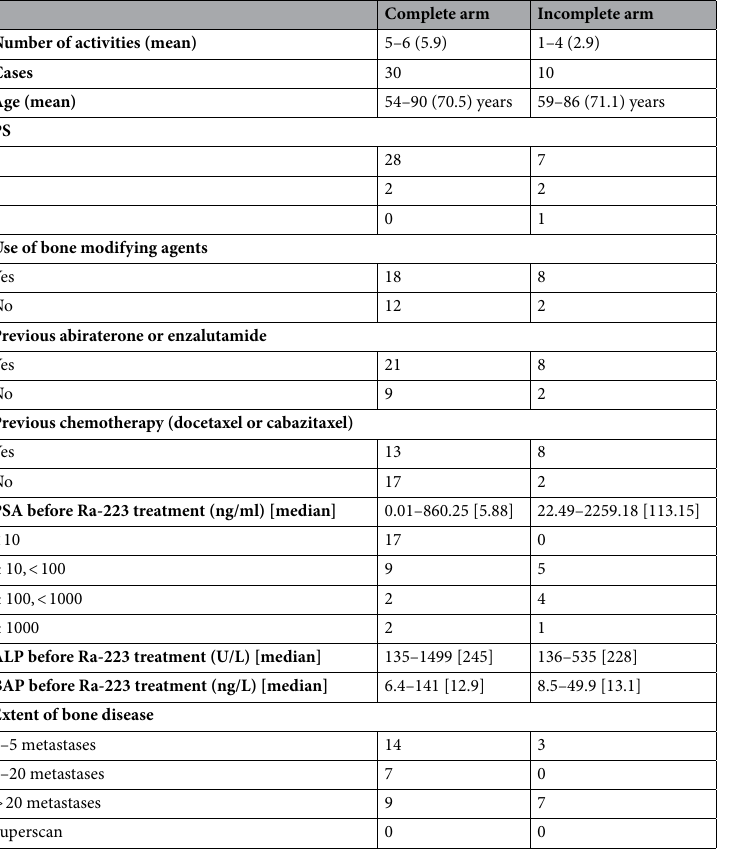
Table 1. Backgrounds of the study patients. PS: performance status; PSA: prostate specific antigen; ALP: alkaline phosphatase; BAP: bone-specific